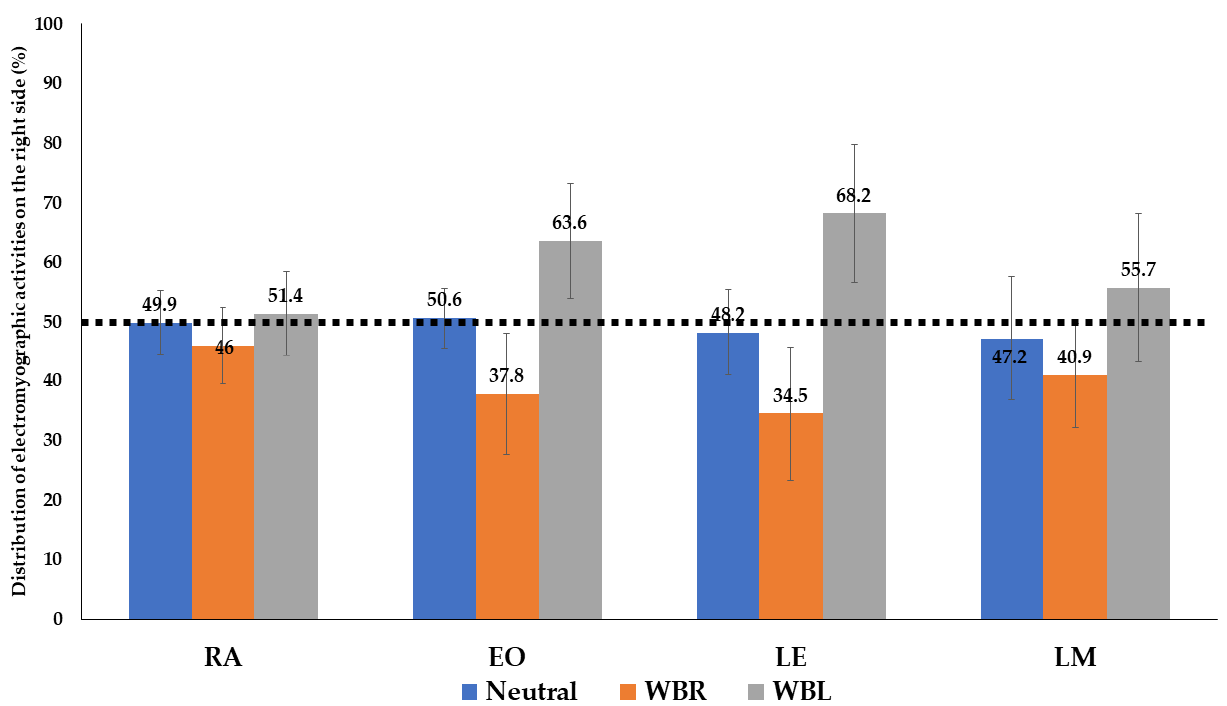
Figure 4. Distribution of electromyographic activities on the right side (%). After right-hand side weight-bearing activity, conducted by lifting the dumbbell (male, 6 kg dumbbell; female, 4 kg dumbbell) using the right hand (orange), the distribution of the right trunk muscle was lower than that of the neutral standing position (blue). After the left-hand side weight-bearing activity, conducted by lifting the dumbbell using the left hand (gray), the distribution of the right trunk muscle was higher than that in the neutral standing position (blue). Abbreviations: RA, rectus abdominis; EO, external oblique; LE, lumbar erector spinae; LM, superficial lumbar multifidus; WBR, weight-bearing with the right hand; WBL, weight-bearing with the left hand.